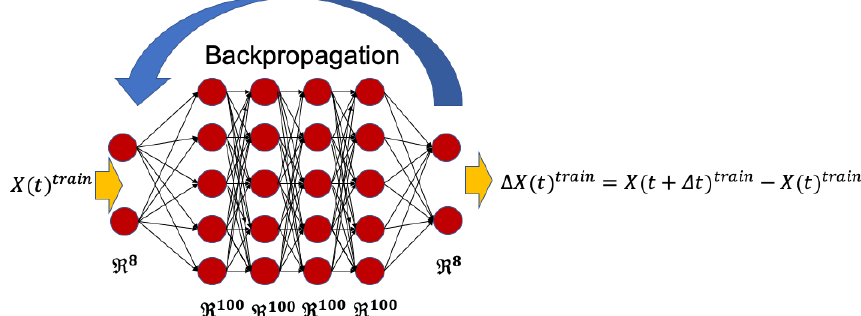
Figure 4. A schematic of ANN, which has four hidden layers each with 100 neurons and an input and an output layer each with 8 neurons (for better illustration, only a few neurons from each layer are shown). Training is performed on pairs of X(t) train and (cid:49)X(t) train , and the weights in each layer are learned through the backpropagation algorithm. During testing (i.e., predictions) (cid:49)X(t) test is predicted for a given X(t) test that is either known from the initial condition or that has been previously predicted. Knowing X(t) test , (cid:49)X(t) test , and (cid:49)X(t − (cid:49)t) test , X(t + (cid:49)t) test is then computed using the Adams–Bashforth integration